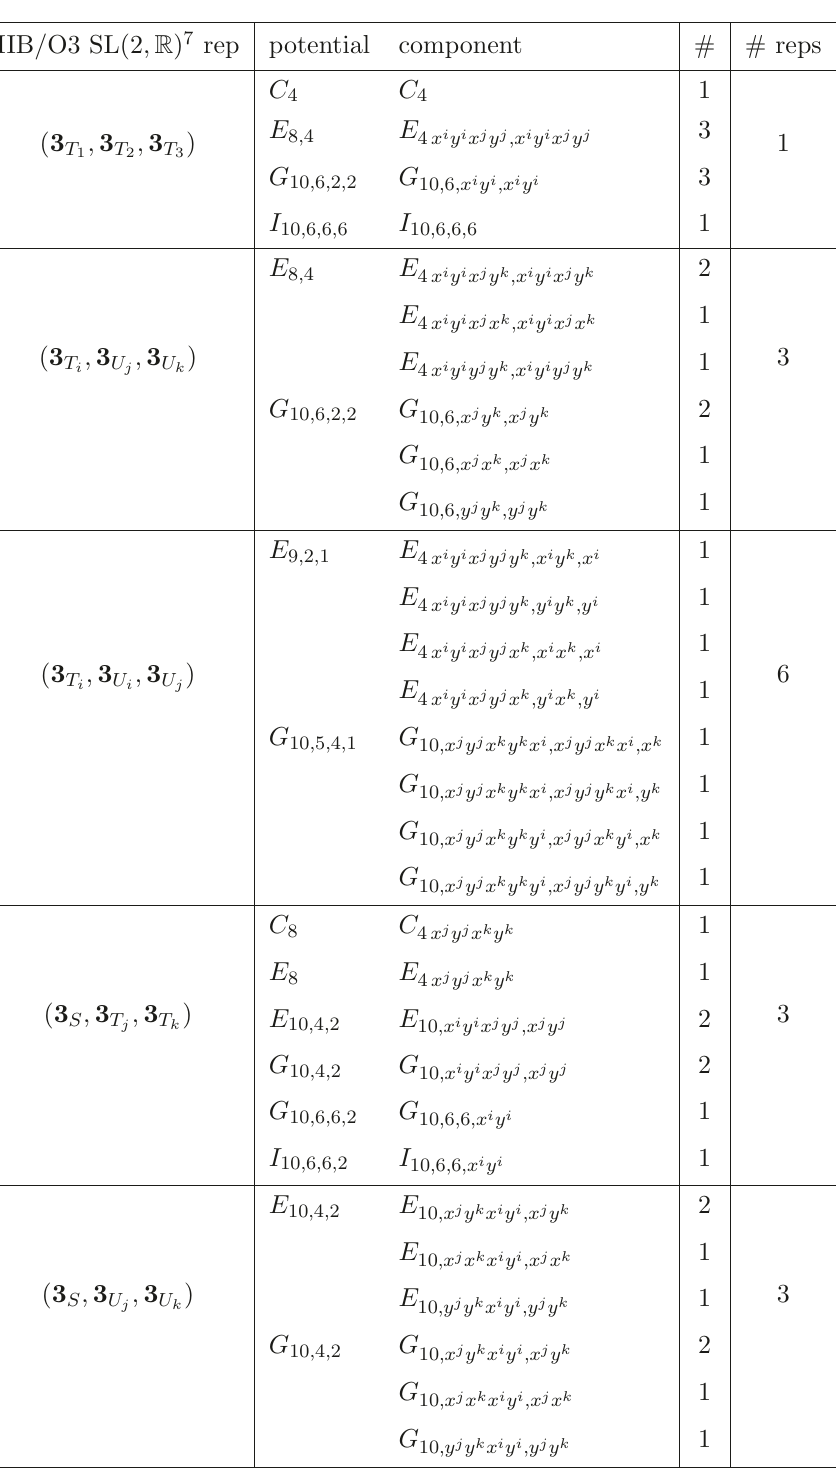
Table 8 . The SL(2 , R ) 7 representations of the IIB/O3 potentials which couple to the allowed space- filling branes, which have α odd. They are all the possible representations with four singlets and three triplets of SL(2 , R ) | U . The branes are 2 7 in number and organise in 16 different representations.